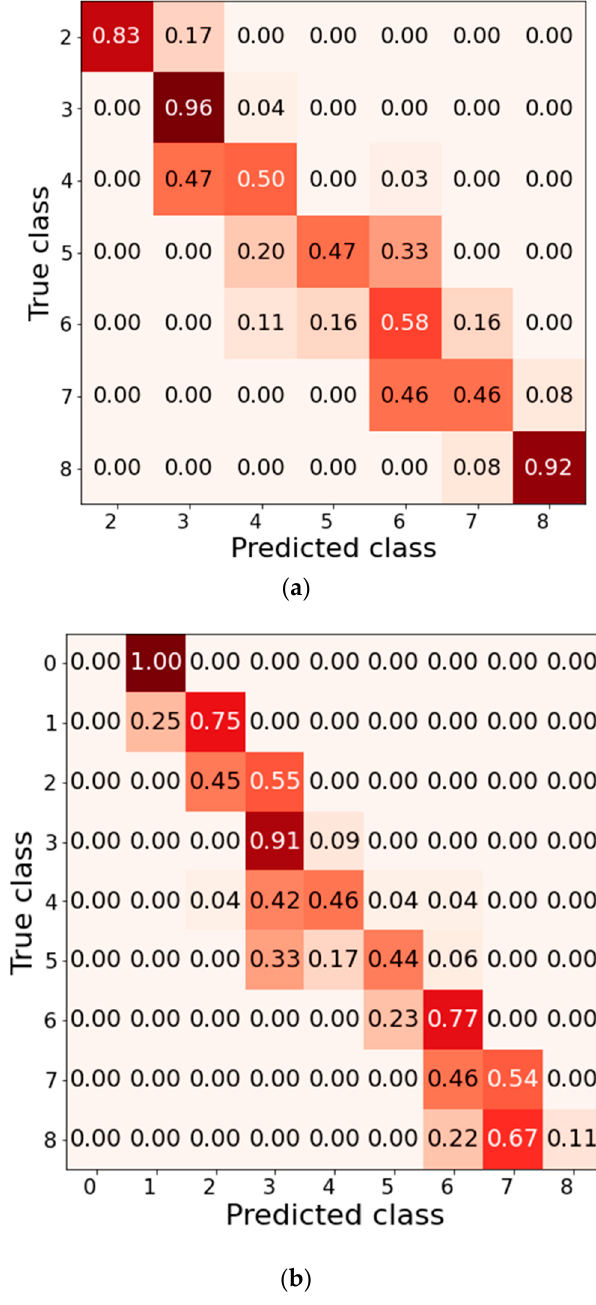
Figure 11. Confusion matrix of the RFC model for the ( a ) the vertical excavation problem and ( b ) the slope